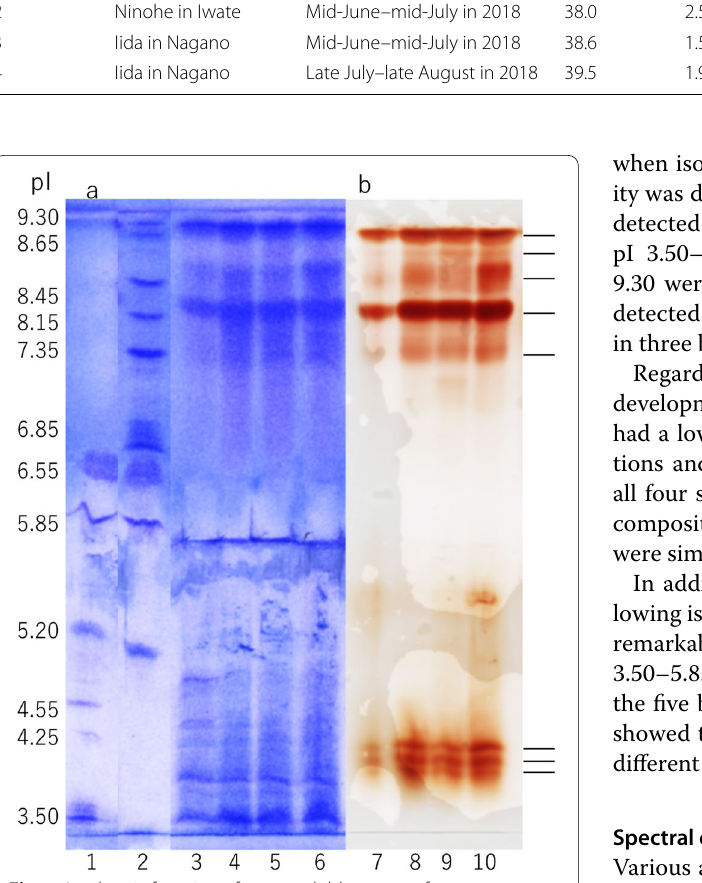
Fig. 1 Isoelectric focusing of water-soluble extracts from acetone powder prepared from the lacquer: a stained with Coomassie Blue R 250; b stained with guaiacol. 1, low pI marker; 2, high pI marker. Lanes 3 to 10 are samples in Table 1. 3, Sample No. 1 in Table 1; 4, No. 2; 5, No. 3; 6, No. 4; 7, No. 1; 8, No. 2; 9, No. 3; 10, No.